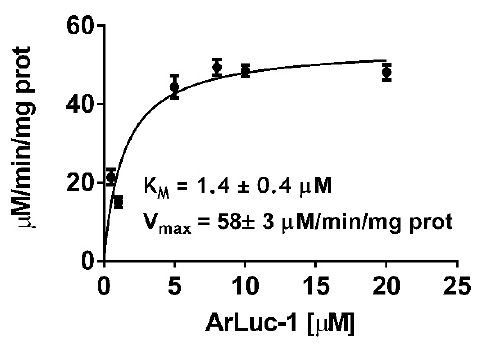
Figure 5. Kinetic study of MAGL activity with ArLuc- 1 . Data are reported as mean ± SD. The curve model is that of the Michaelis–Menten.